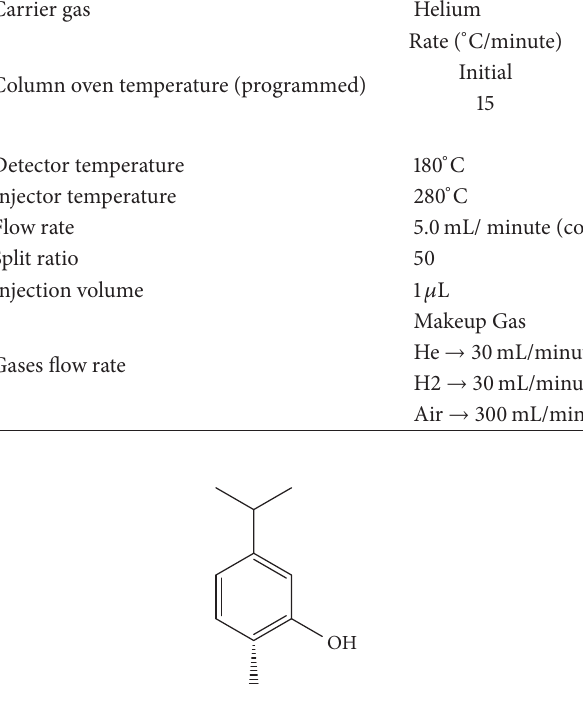
Figure 1: Menthol